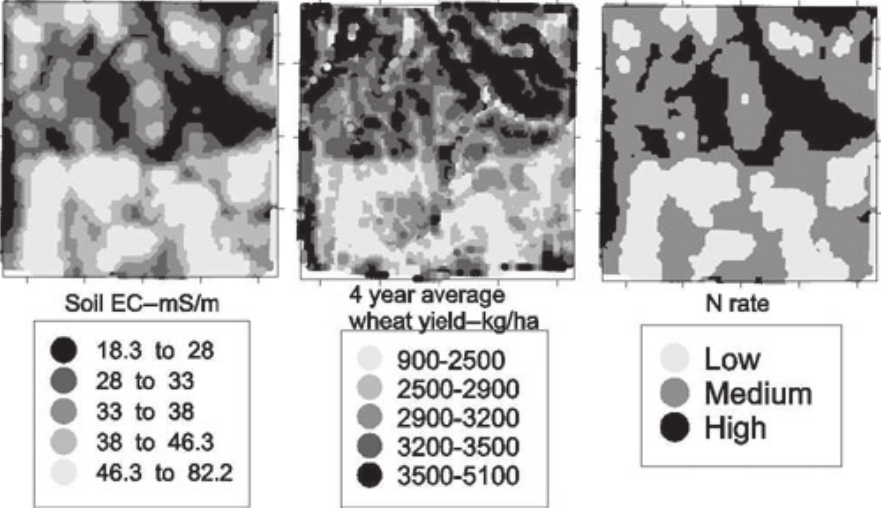
FIGURE 6. Maps of EC, historical crop yields, and a yield goal-based N rate from a 65-ha